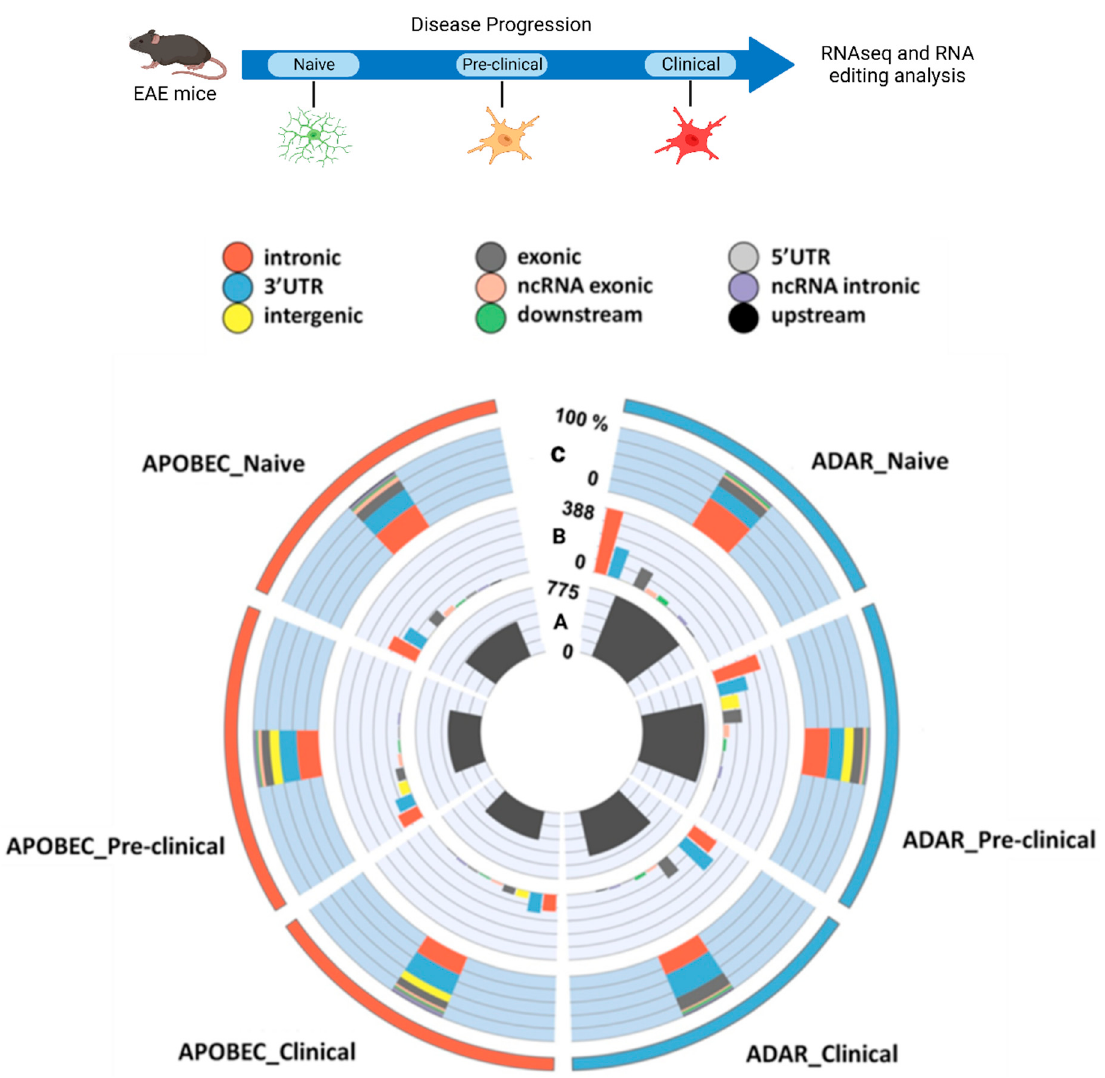
Figure 1. RNA editing is reduced in murine microglia and shifts towards 3 ′ UTR in clinical disease. Graphic representation of murine microglia RNA editomes, following EAE induction. Presented data are based on meta-analysis of previously published RNA-seq data (GSE59725, [36]), following an in-house developed pipeline for RNA editing events identification. Ring A: Absolute number of RNA editing events identified per editing-mediating enzyme and time-point (naïve, pre-clinical, clinical). Both ADAR- and APOBEC-mediated editing were reduced as disease progressed (for de- tailed numbers, please also see Tables S2–S4). Ring B: Genomic distribution (color code legend on top of the graph) of RNA editing events (absolute numbers) for each RNA-editing mediating en- zyme and time-point. A shift towards increased 3 ′ UTR editing was observed as disease progressed. Ring C: Percent genomic distribution of editing events across functional gene regions (color code legend on top of the graph). For a detailed list of editing events identified per editing enzyme and time-point, please refer to Supplementary Files 1 and 2. Top panel figure created in Biorender.com (accessed on 9 September 2022). Considering naïve microglia, A-I changes (775) were almost two-fold over-repre- sented, compared to C-U (450) (Figure 1, Ring A, Tables S3 and S4), further verifying the previously reported abundance of A-I editing. In naïve microglia, most editing events were identified in non-coding regions (intronic: 46.4%, 3 ′ UTR: 25.2%, ncRNA-exonic: 4.5%, ncRNA-intronic: 2.5%, upstream/downstream: 4.2%, 5 ′ UTR: 1.6%), while exon-oc- curring editing represented the 15.4% of total editing (Table S2). This genomic distribution